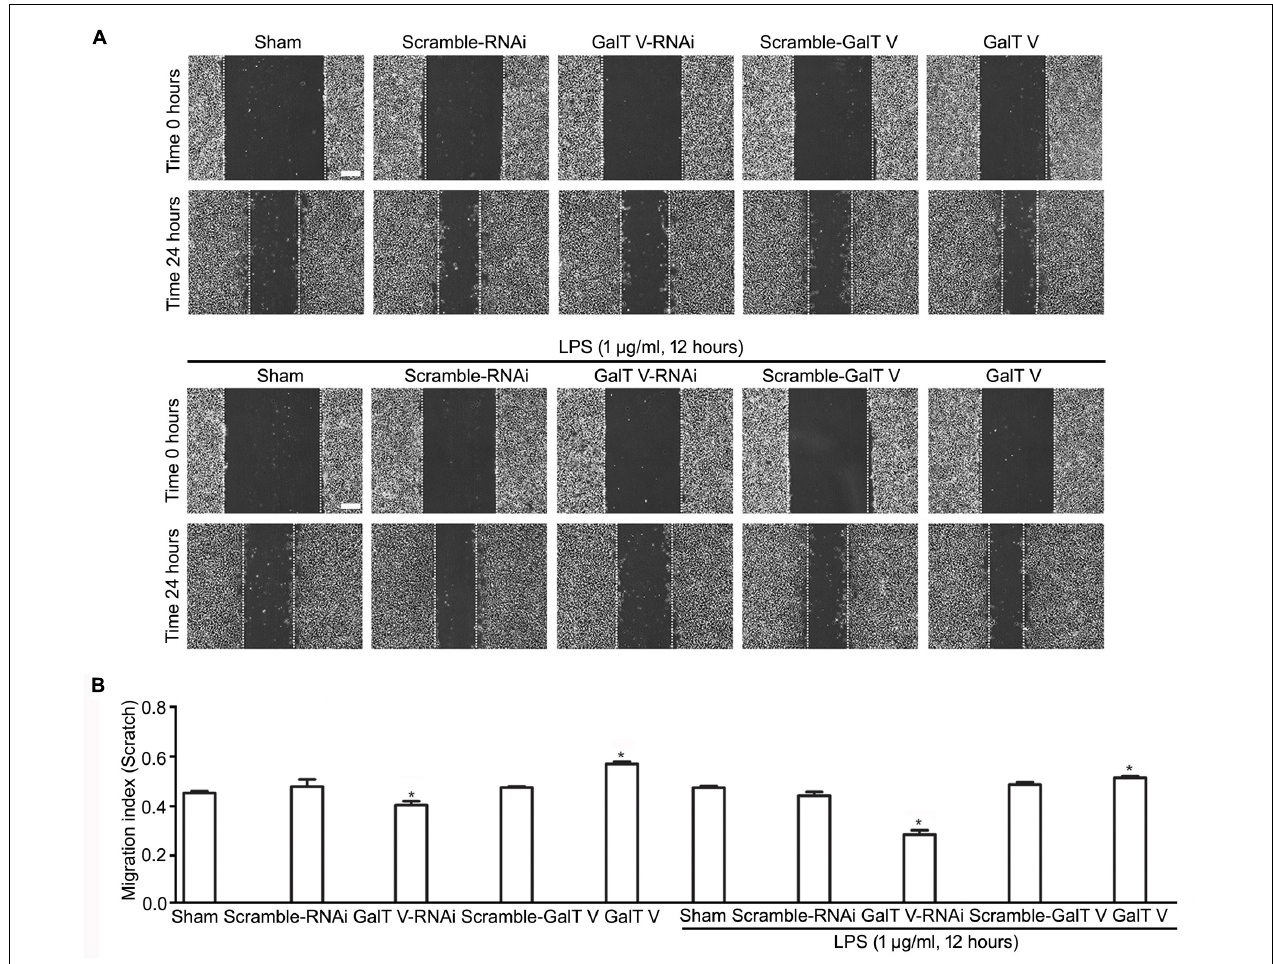
FIGURE 3 | Acceleration of β -1, 4-GalT V on wound healing. HAPI cells with designated constructions as indicated were treated with LPS (1 µ g/ml, 24 h). (A) Representative images for wound recovery; scale bar, 100 µ m. (B) Quantification of wounded area [migration index (scratch) = wounded size after 24 h/initial wound area)]. Groups significantly different from the non-treated sham group were marked by asterisks. Graphs show mean ± SD; n = 3; * p <